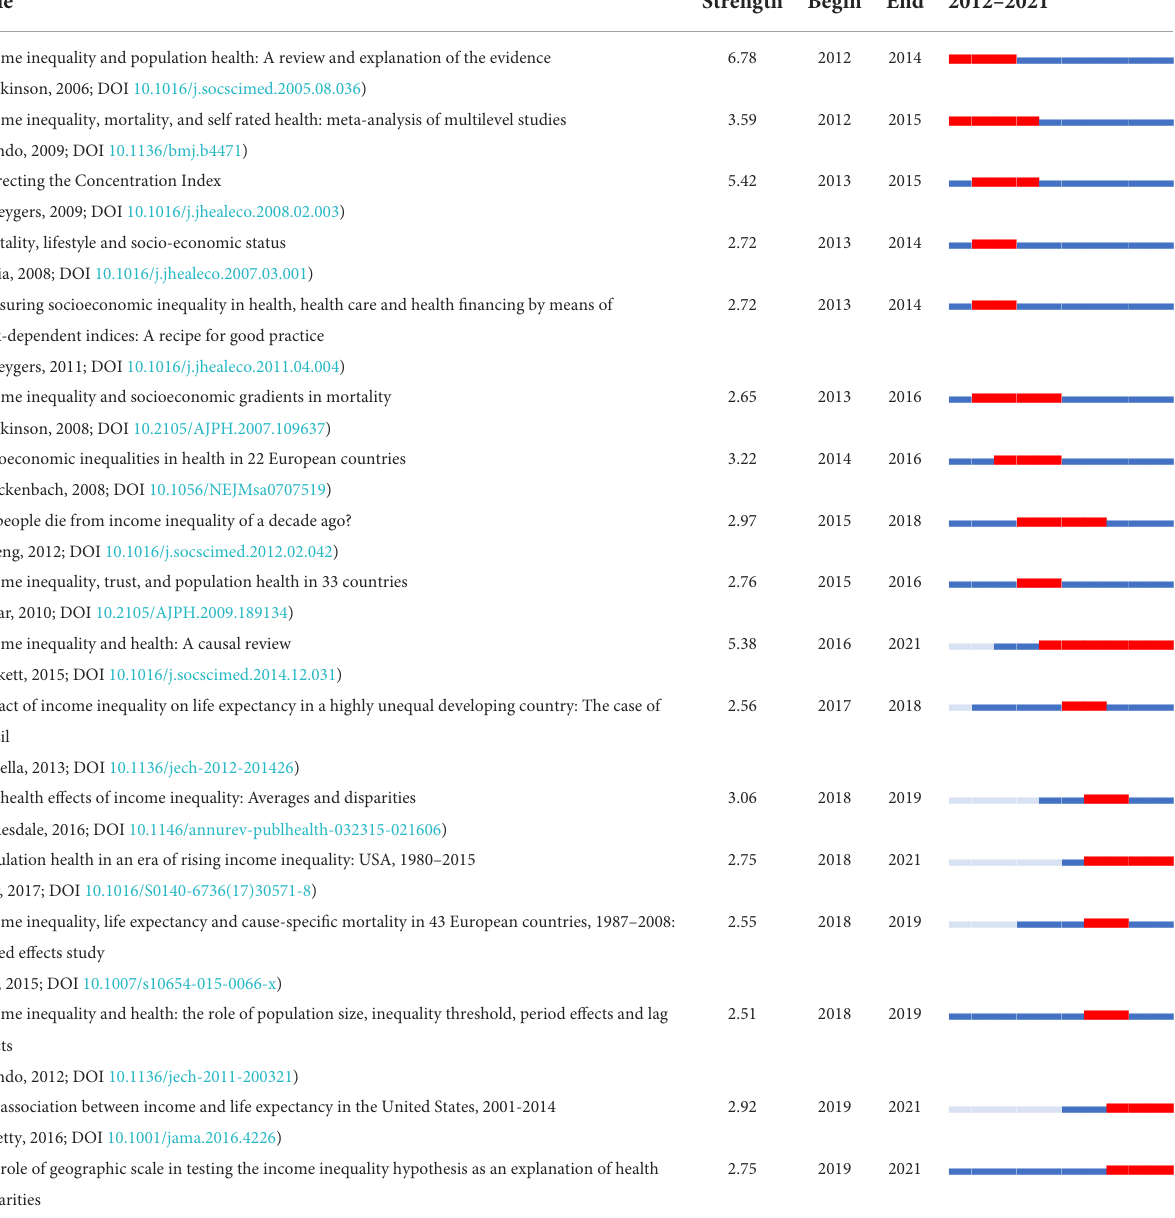
TABLE 7 Top 17 references with strongest citation bursts in